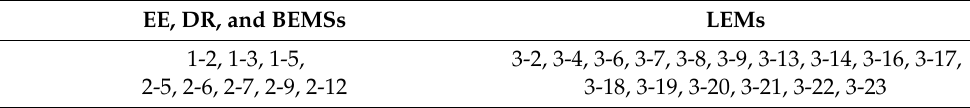
Table 1. Barriers related to